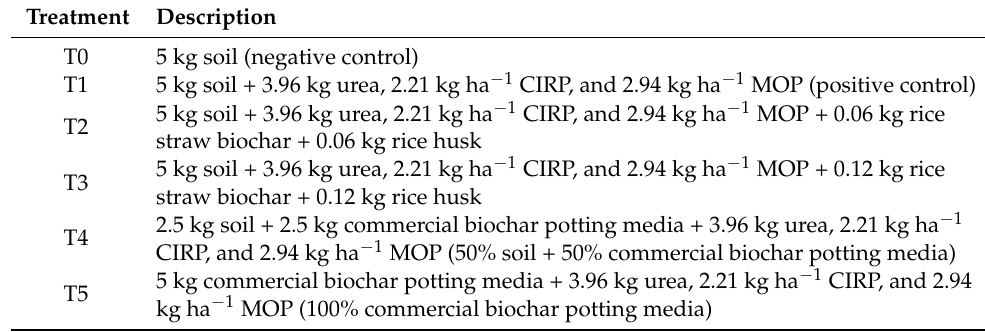
Table 2. Treatments evaluated in pot